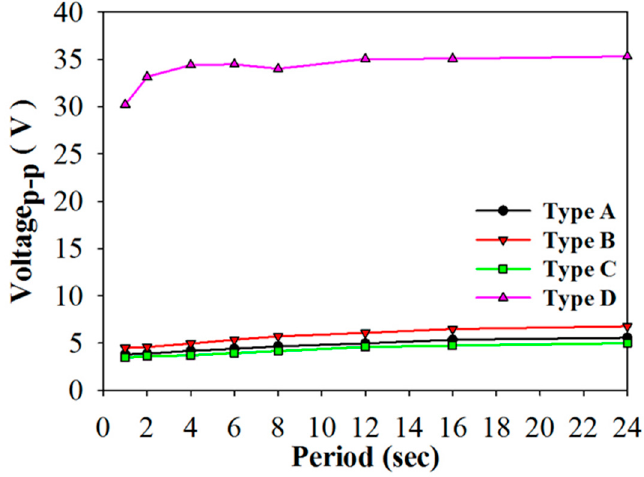
Figure 11. Relationship between the induced peak to peak voltage and period for using the PZT cell with various structures.